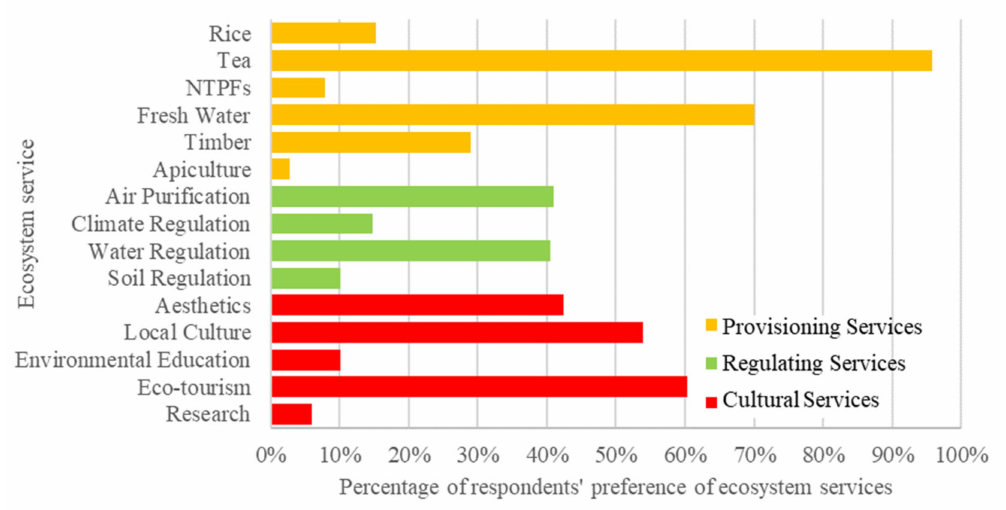
Figure 3. Tea farmers’ preference of ecosystem services concerning their overall importance to life (NTFP: non-timber forest products).